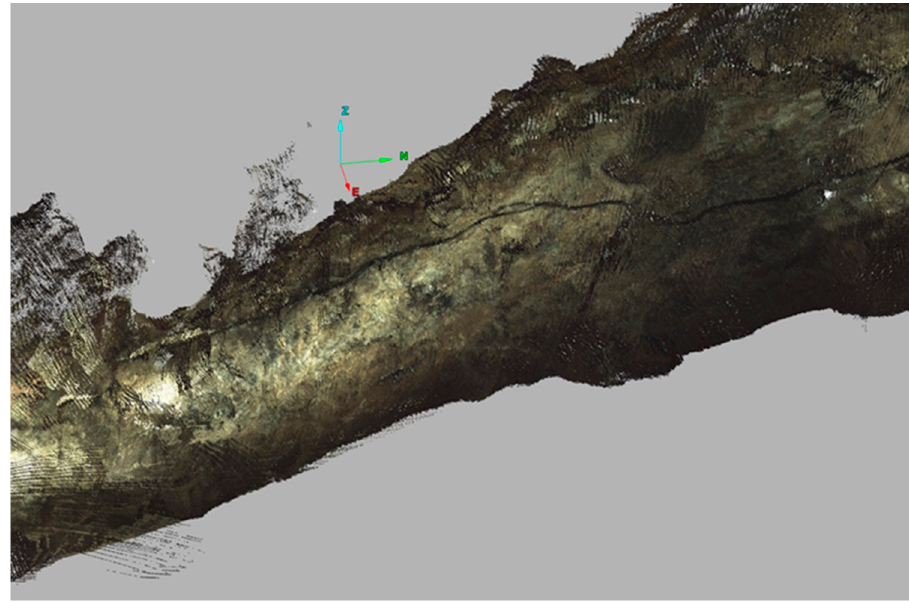
Figure 2. Close-up view of a scanned section (Blue polygon from Figure 1) of part of the Masson Cavern at the Heights of Abraham,